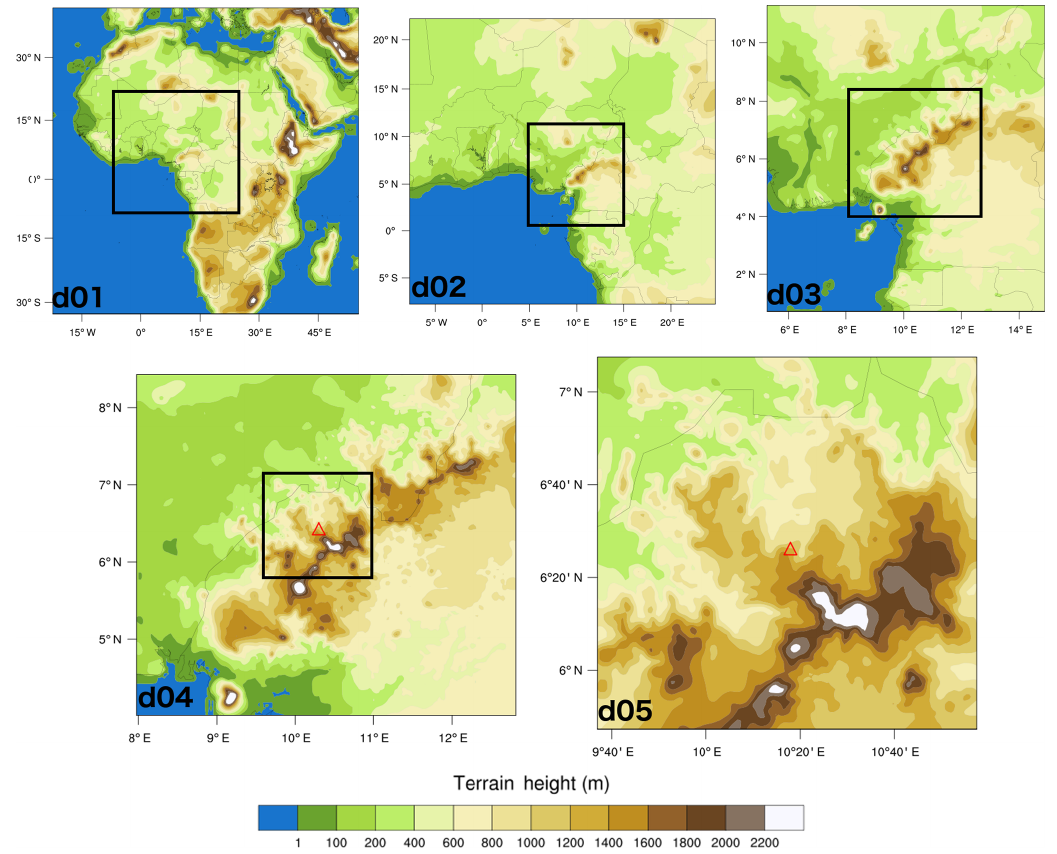
Figure 5. WRF-ARW domains for the Nyos run. The model configuration consists of one parent domain (d01) at 81km horizontal resolution and four nests (d02 to d05) at 27, 9, 3, and 1km resolution centred at the Lake Nyos (red triangle, not on scale). Colour contours indicate the WRF-ARW model topography at each resolution.